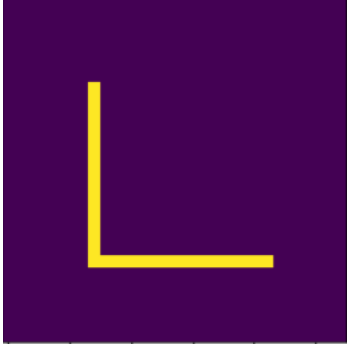
Figure 16. Mirrored.